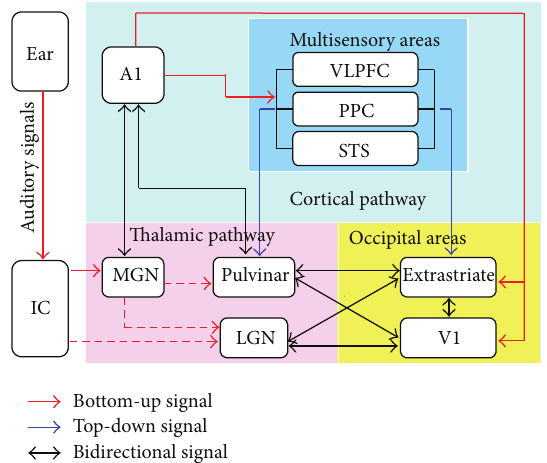
Figure 1: Schematic of neural pathways that convey auditory signals into visual areas. The solid line represents the existing connections in the normal sighted animals or human; dash line represents the rewired connections after early visual deprivation; arrows with red, blue, and black color represent the bottom-up, top-down, and bidirectional auditory signals, respectively. All these connections are confirmed by previous animal or human studies (for details see Section 3). A1: primary auditory cortex; IC: inferior colliculus; MGN: medial geniculate nucleus; LGN: lateral geniculate nucleus; PPC: post parietal cortex; STS: superior temporal cortex; VLPFC: ventral lateral prefrontal cortex; V1: primary visual cortex.